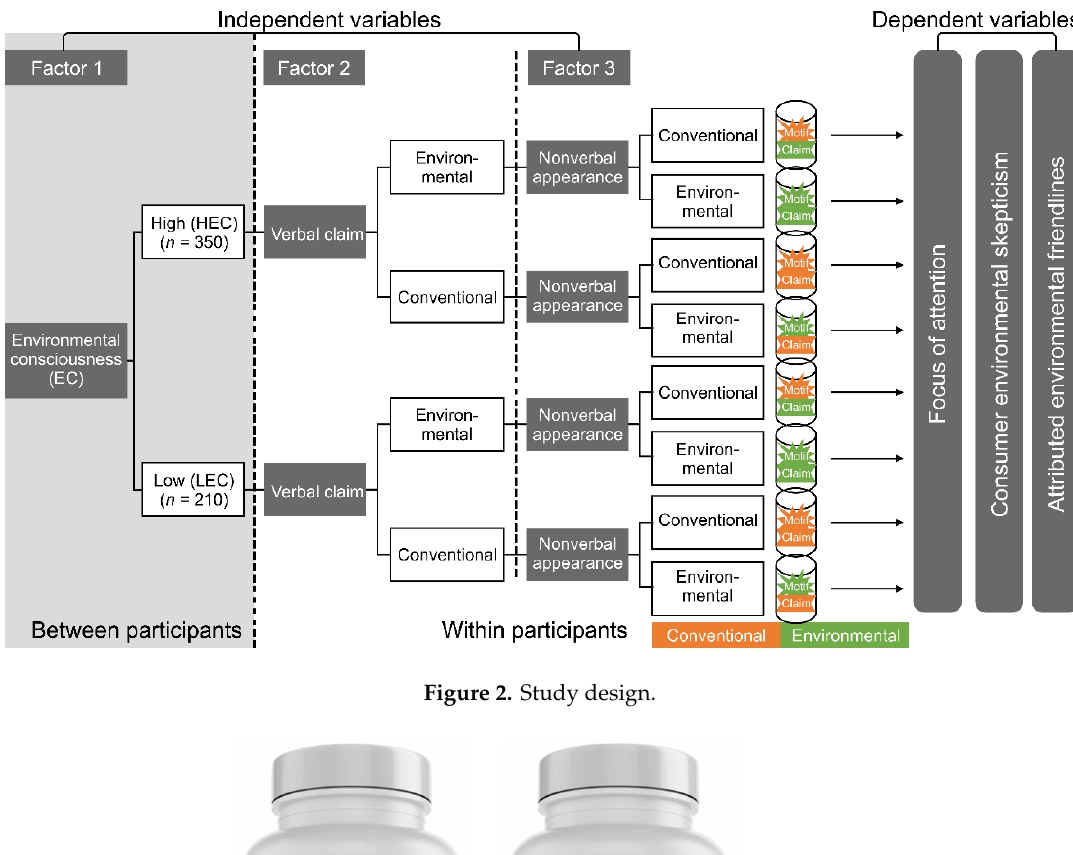
Figure 2. Study design. Designs 2020 , 4 , x FOR PEER REVIEW